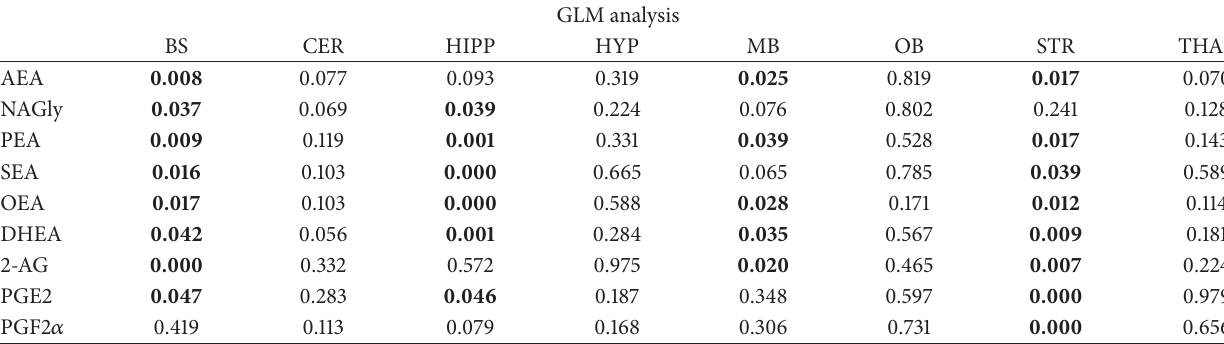
Table 1: General linear model analyses of each lipid profiled by brain area and treatment